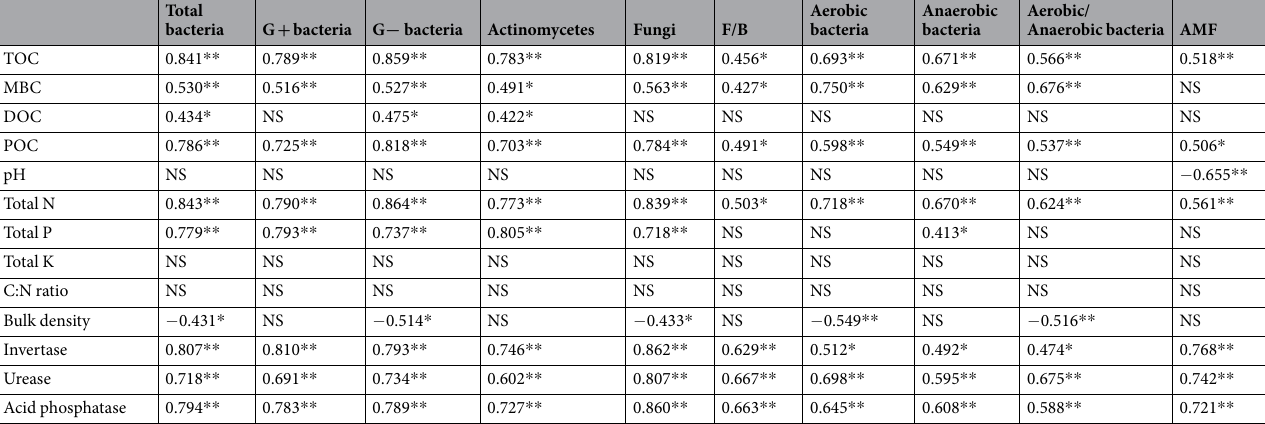
Table 5. Pearson’s correlation analysis of microbial parameters and soil physicochemical properties. NS: not significant; * p < 0.05; ** p <